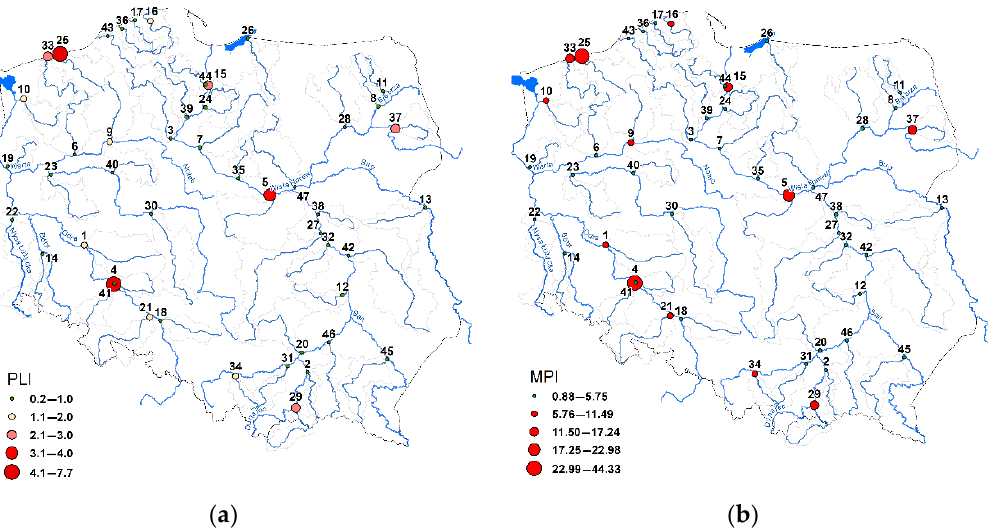
Figure 5. River sediment contamination by HMs based on PLI ( a ) and MPI ( b ) indices. The num- bers of sampling points are listed in the Appendix A. of sampling points are listed in the Appendix A.